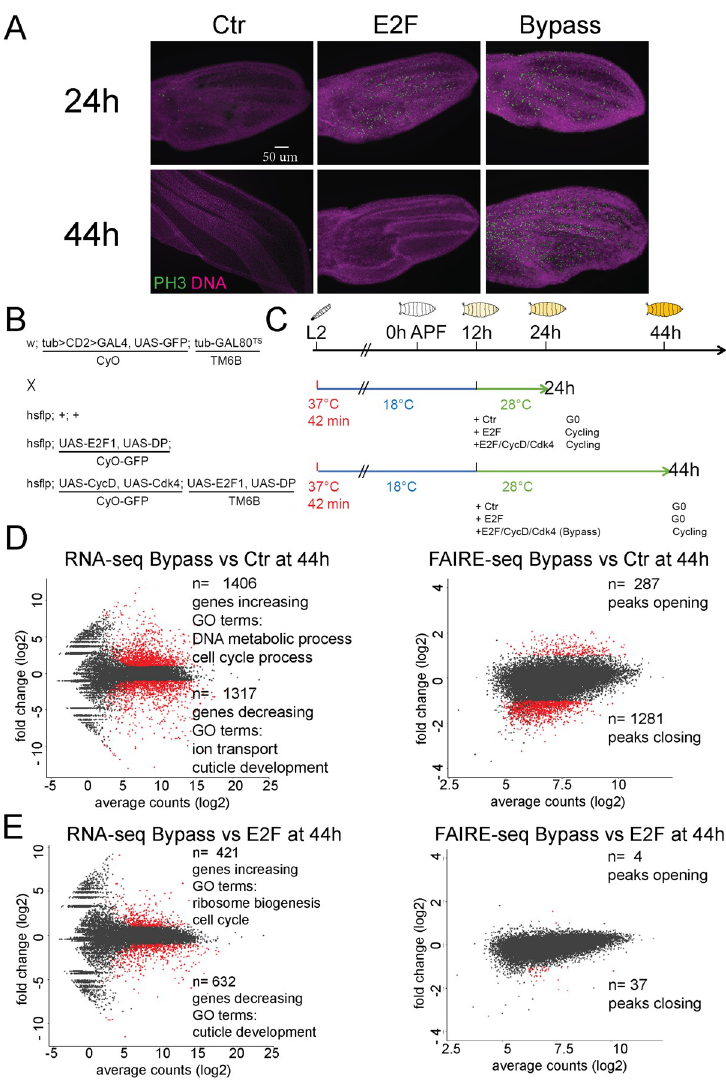
Fig 3. Global impacts of cell cycle exit disruption on gene expression and open chromatin. (A) G0 can be delayed to 36 h or bypassed beyond 50 h through short-term expression of E2F or E2F + CycD/Cdk4. Transgenes were overexpressed in the dorsal layer of wing epithelia under the control of Apterous-Gal4/Gal80 TS from 12 h APF. Twenty-four-hour and 44-h wings were immunostained for ph3. (B, C) Genotype and scheme of RNA-seq and FAIRE-seq experiments to disrupt cell cycle exit during metamorphosis. (D, E) MA plots of RNA and FAIRE changes comparing bypassed exit (E2F + CycD/cdk4) between Ctr (D) and delayed cell cycle exit (E2F) (E) at 44 h. Abundant changes in expression of cell cycle genes, ribosome biogenesis, and cuticle formation genes are observed, while chromatin accessibility is nearly identical between conditions in which cells enter a delayed G0 versus continue cycling. The underlying data in Fig 3D and 3E can be found within S3 Data. APF, after puparium formation; Cdk, cyclin-dependent kinase; Ctr, control; CycD, Cyclin D; CyO, Curly O balancer; DP, dimerization partner; E2F, E2F transcription factor; FAIRE, formaldehyde-assisted isolation of regulatory elements; FAIRE-seq, FAIRE sequencing; Gal80 TS , temperature-sensitive Gal80; GO, Gene Ontology; hsflp, heatshock-flippase; MA plot, scatter plot onto M (log ratio) and A (mean average) scales; ph3, phosphohistone H3; RNA-seq, RNA sequencing; TM6B, TM6B balancer; UAS, upstream activation sequence. are postmitotic, the E2F + CycD wings are still cycling, allowing us to distinguish the effects of E2F overexpression from those of preventing cell cycle exit.